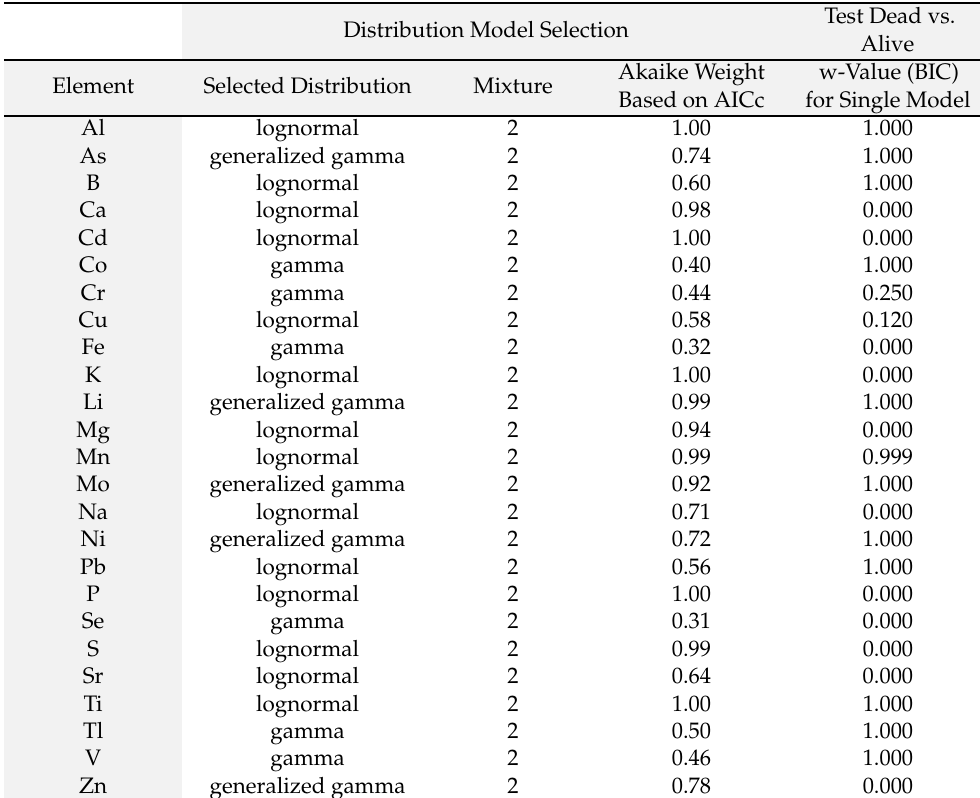
Table 3. Comparison of fit of censored gamma, lognormal, Weibull, and generalized gamma distribu- tions for the elements analyzed in 238 blood samples of olive ridley sea turtles nesting in Oaxaca, Mexico [9]. Only the selected model based on Akaike weight using AICc (i.e., Akaike information criterion with a small sample correction) is shown. The column “Test dead vs. alive” shows the Akaike weight based on the Bayesian information criterion (BIC) for a single model for both alive and dead turtles on the